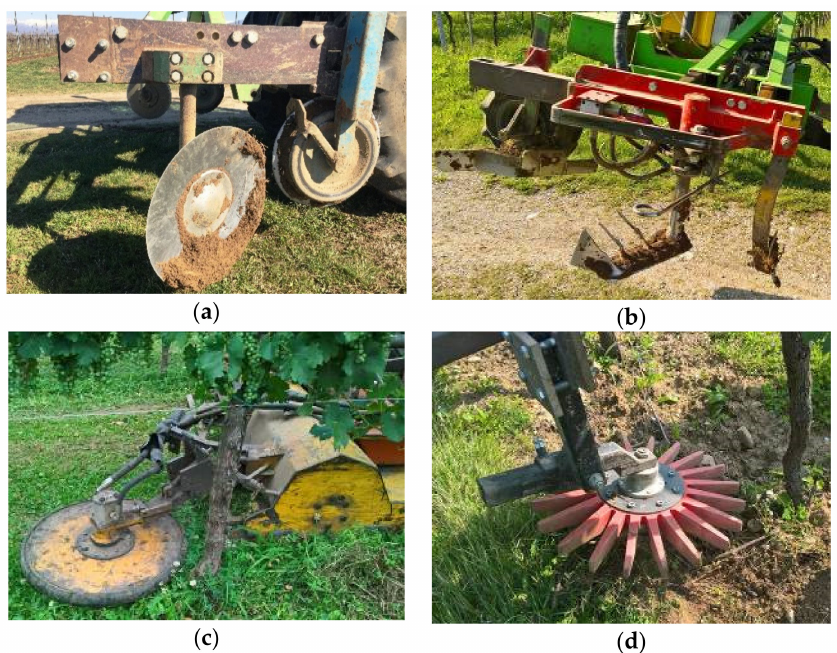
Figure 2. ( a ) The disc cultivator; ( b ) the blade weeder; ( c ) the mower; and ( d ) the finger